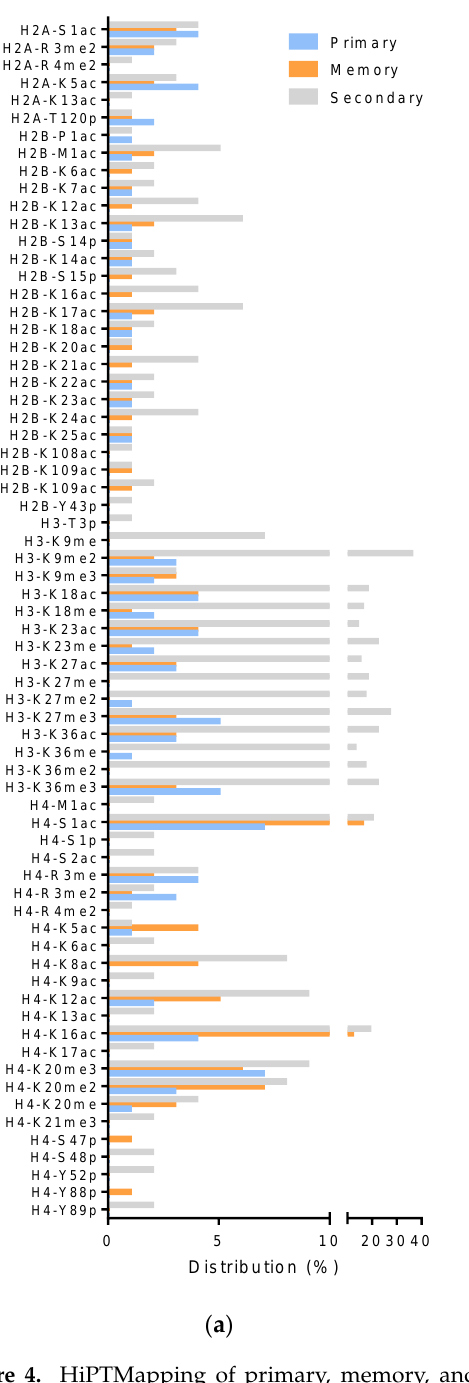
Figure 4. HiPTMapping of primary, memory, and secondary CD8 T cells. ( a , b ) Histones were purified from T cells and subjected to RPLC – MS/MS using Orbitrap Velos with alternative CID/ETD. Raw datasets were searched against the mouse top-down database. PTMs including acetylation; mono-, di-, and trimethylation; and phosphorylation were detected. The occurrence of each modification per proteoform was combined to yield the sum of each specific PTMs per core histone. ( a ) ANOVA ( p < 0.0001) was performed followed by Tukey’s multiple comparisons test: Teff 1 , vs. Tm ( p = 0.17), Tm vs. Teff 2 ( p < 0.0001), and Teff vs. Teff 2 ( p < 0.0001); ( b ) PTMs were separated into known activation marks (H2A-S1p, H2A-K5ac, H3-K36me2, H3-K9ac, H3-K27ac, H2B-K12ac, H3-K18ac, H3-K23ac, H3-K36ac, H3-K36me3, H4-K5ac, H4-K8ac, H4-K12ac, H4-K8ac, H4-R3me2, and H4-K16ac) and repressive marks (H3-R8me2, H3-K9me2, H3-K9me3, H3-K27me3, H4-K20me2, H4-K20me3, H4-K20me). Statistical comparison was with ANOVA ( p = 0.007) followed by Tukey’s multiple comparisons test ( p <